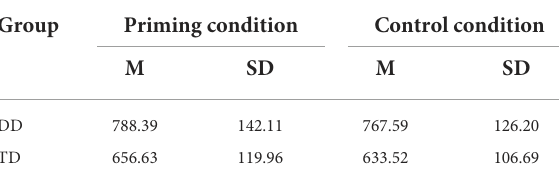
TABLE 2 Mean reaction times (ms) of the DD and TD groups under the two